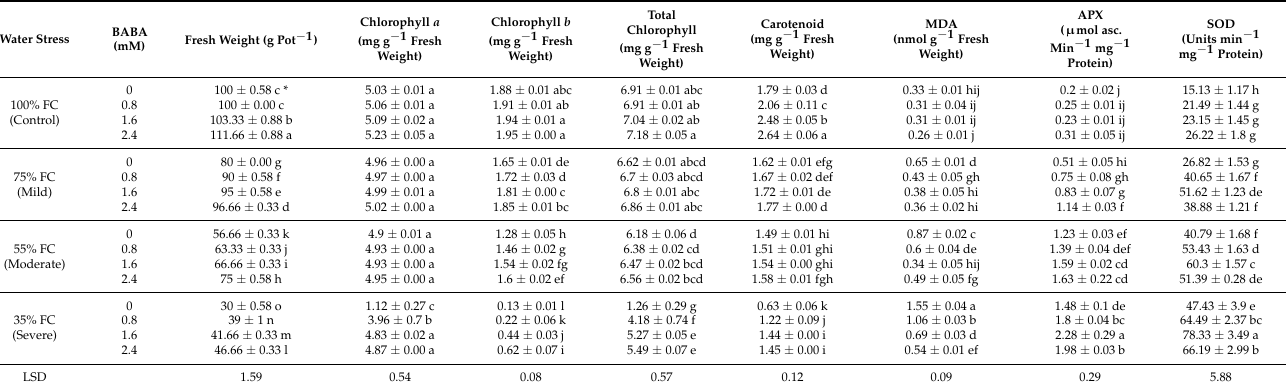
Table 1. Effects of the foliar application of BABA on the growth and physiological parameters in grapefruit mint plants under different water stress.